Question: According to the figure, is the described quantity increasing or decreasing?
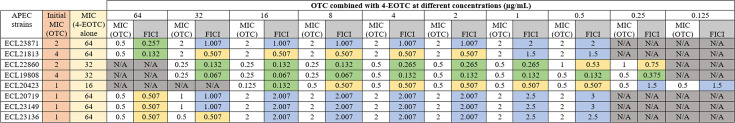
Answer: increasing